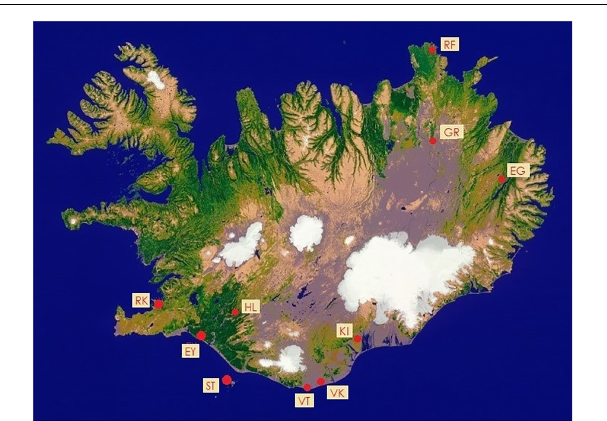
FIGURE 1 | Vegetation map of Iceland. Source: Based on data from National Land Survey of Iceland (http://www.lmi.is/en/okeypis-kort/). ∗ Station locations added: Grímsstaðir (GR), Raufarhöfn (RF), Egilsstaðir (EG), Reykjavik (RK), Eyrarbakki (EY), Hæll (HL), Stórhöfði (ST), Vatnsskarðshólar (VT), Vík í Mýrdal (VK), Kirkjubæjarklaustur (KI).